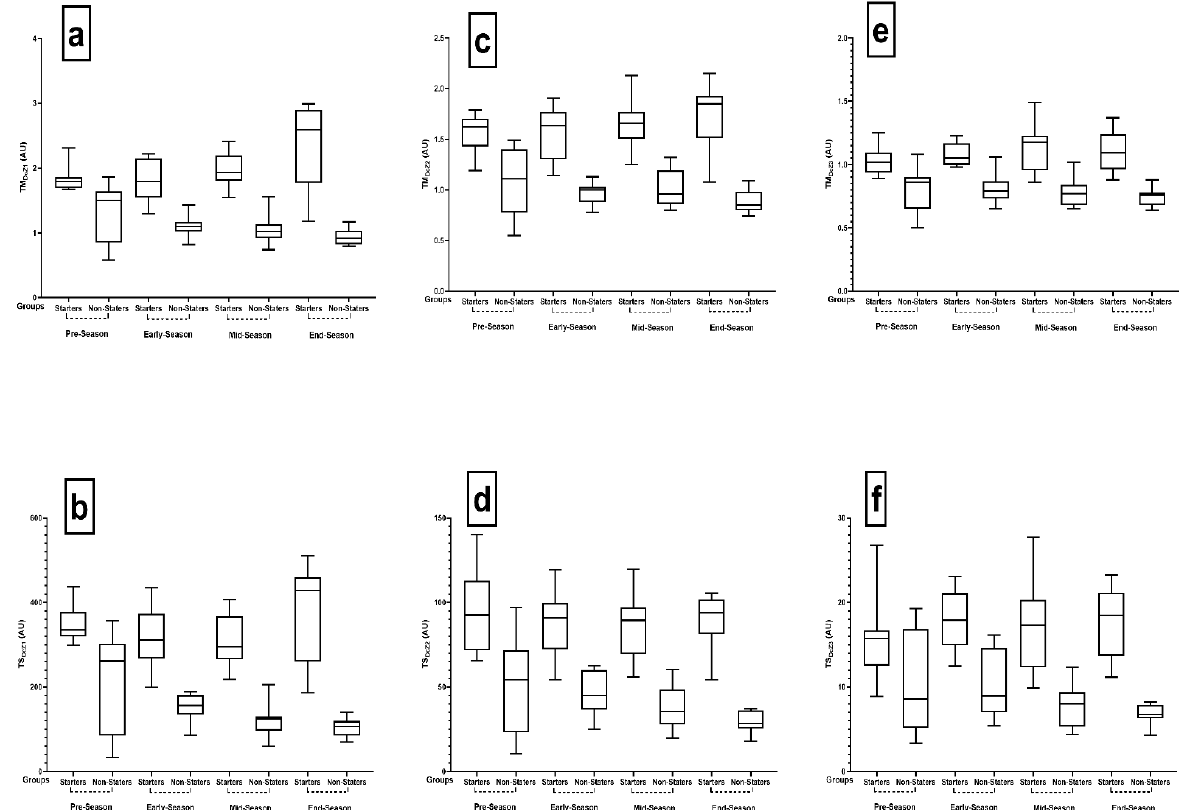
Figure 2. Pairwise comparisons between season periods in TM and TS in all DcZ for both non- and starter players. Abbre-